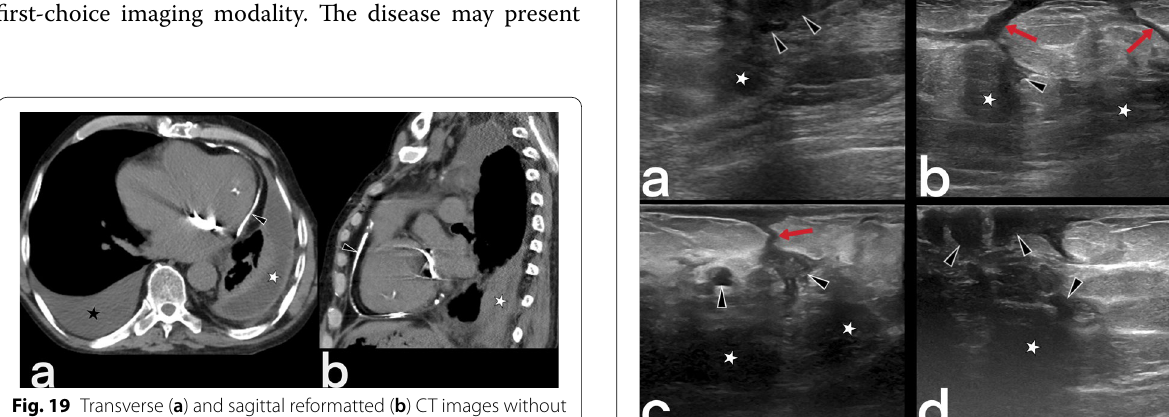
Fig. 20 Ultrasound images from four different female patients ( a – d ). Abscesses (arrowheads), sinus tracts (arrows), and hypoechoic parenchymal edema areas